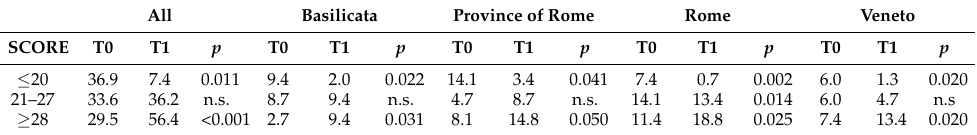
Table 4. Classification of the students that improved their performance in planning the weekly menu in three categories of a rating scale. The students that improved their performance at T1 with respect to T0 were assigned to one of three categories of a rating scale considered indicative of different levels of performance (low, ≤ 20; medium, 21–27; and high, ≥ 28 points) on the basis of the scores obtained at T0 and T1. All Basilicata Province of Rome